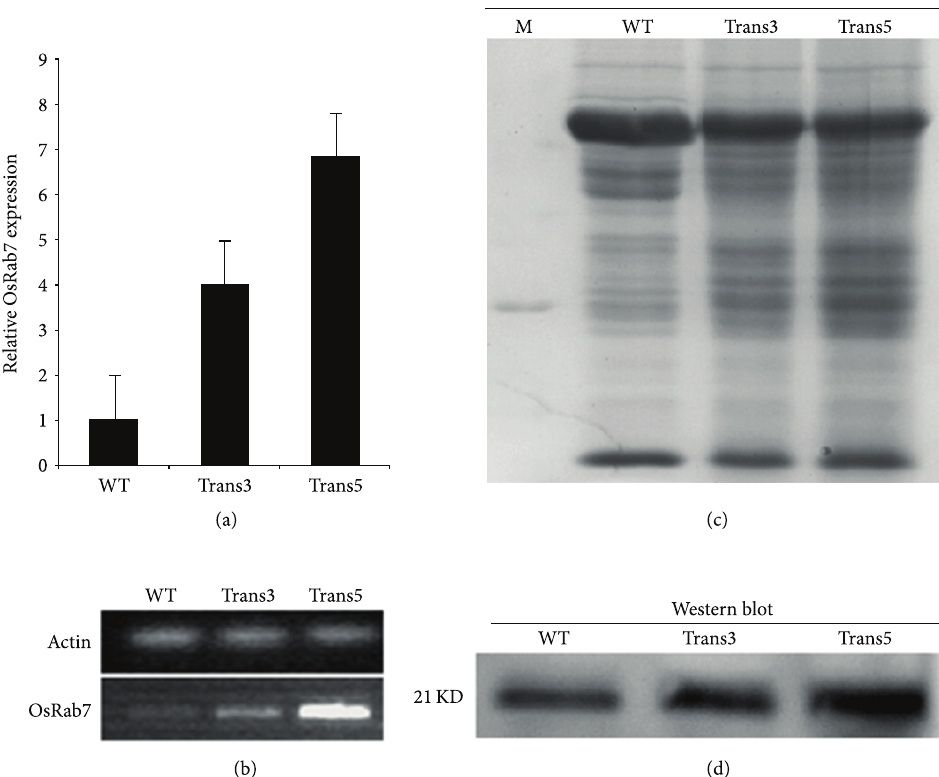
Figure 1: Expression of the OsRab7 gene in transgenic rice plants. (a) Real-time quantitative PCR analysis in transgenic plants. Total RNA was extracted from transgenic plant, and wild-type plants. Actin was used as an internal control. (b) OsRab7 expression in transgenic plants was determined by semiquantitative RT-PCR analysis. (c) a SDS-PAGE showed the protein content in the samples. Equal concentrations of protein extracts from the rice samples were separated by SDS-PAGE. (d) Western blot analysis of transgenic rice plants. All lanes were run with equal amounts of the protein extracts from the rice